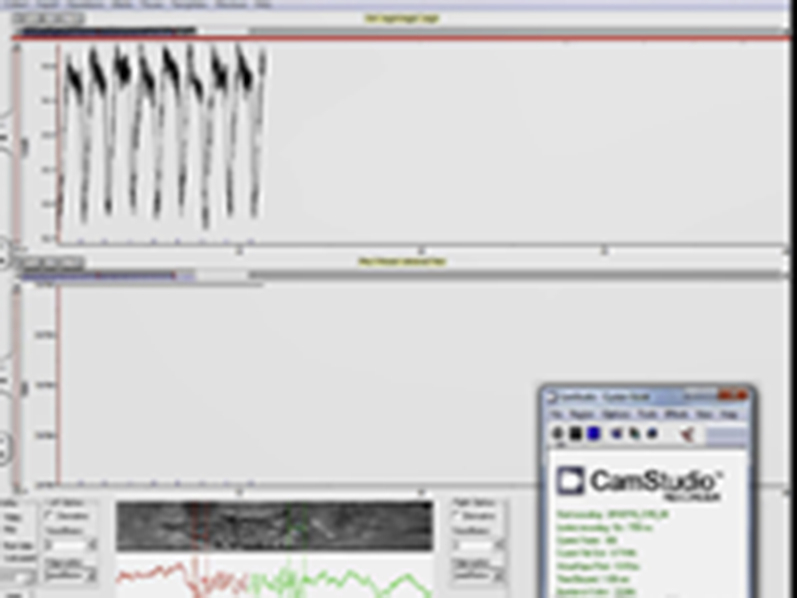
Supplemental Video 1Representative IonOptix video recording of a hiPSC-CM plated on a nanopatterned surface and contracting at 1.5 Hz.